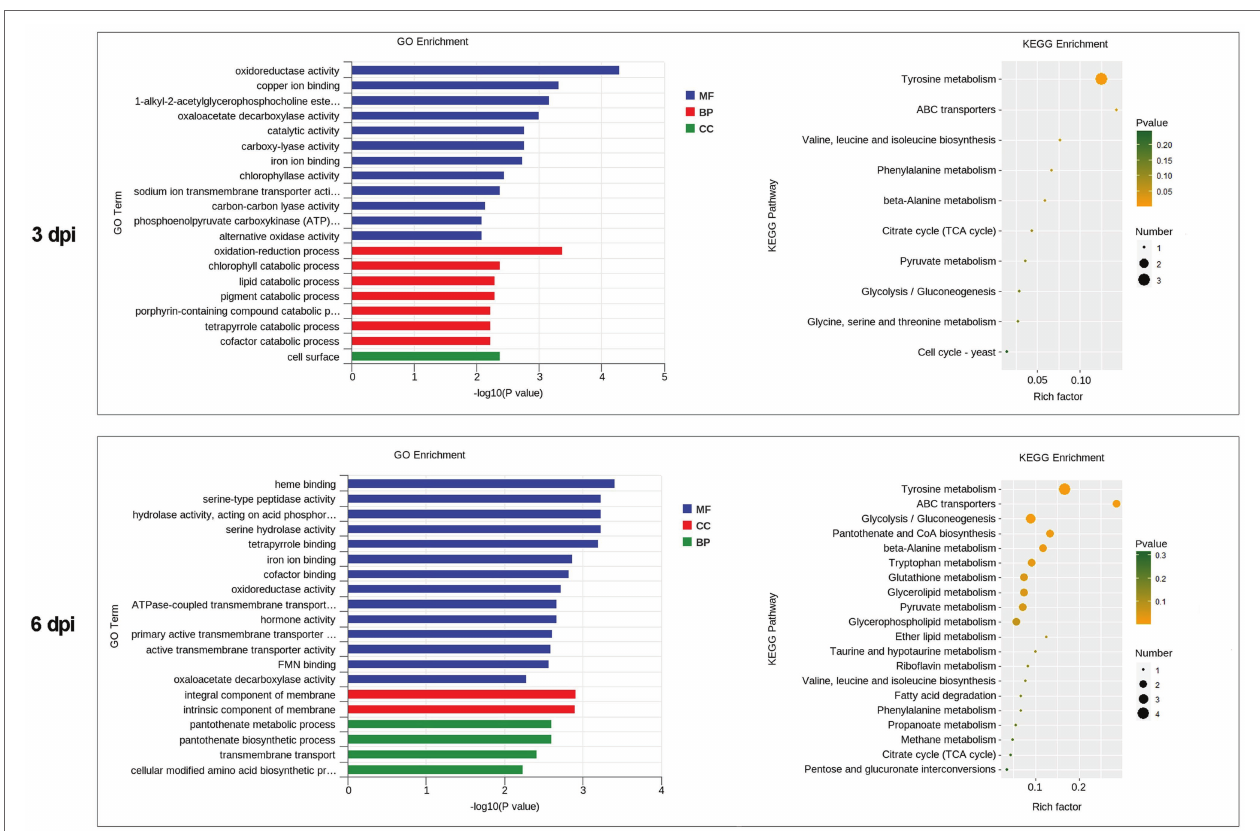
FIGURE 6 | Functional enrichment analyses for DEGs in M. sextelata at 3 and 6 days post-inoculation. GO enrichment analyses, GO term enrichment values of p are indicated on the x -axis. BP, biological process; MF, molecular function; CC, cellular component. KEGG enrichment analyses, x -axis represents the rich factor; the dot size indicates the number of DEGs involved in the pathway; Color bars on the right represent the values of p of the KEGG pathway. 3 and 6 dpi represent 3 and 6 days post-inoculation. DEGs, differentially expressed genes; GO, gene ontology; KEGG, kyoto encyclopedia of genes and